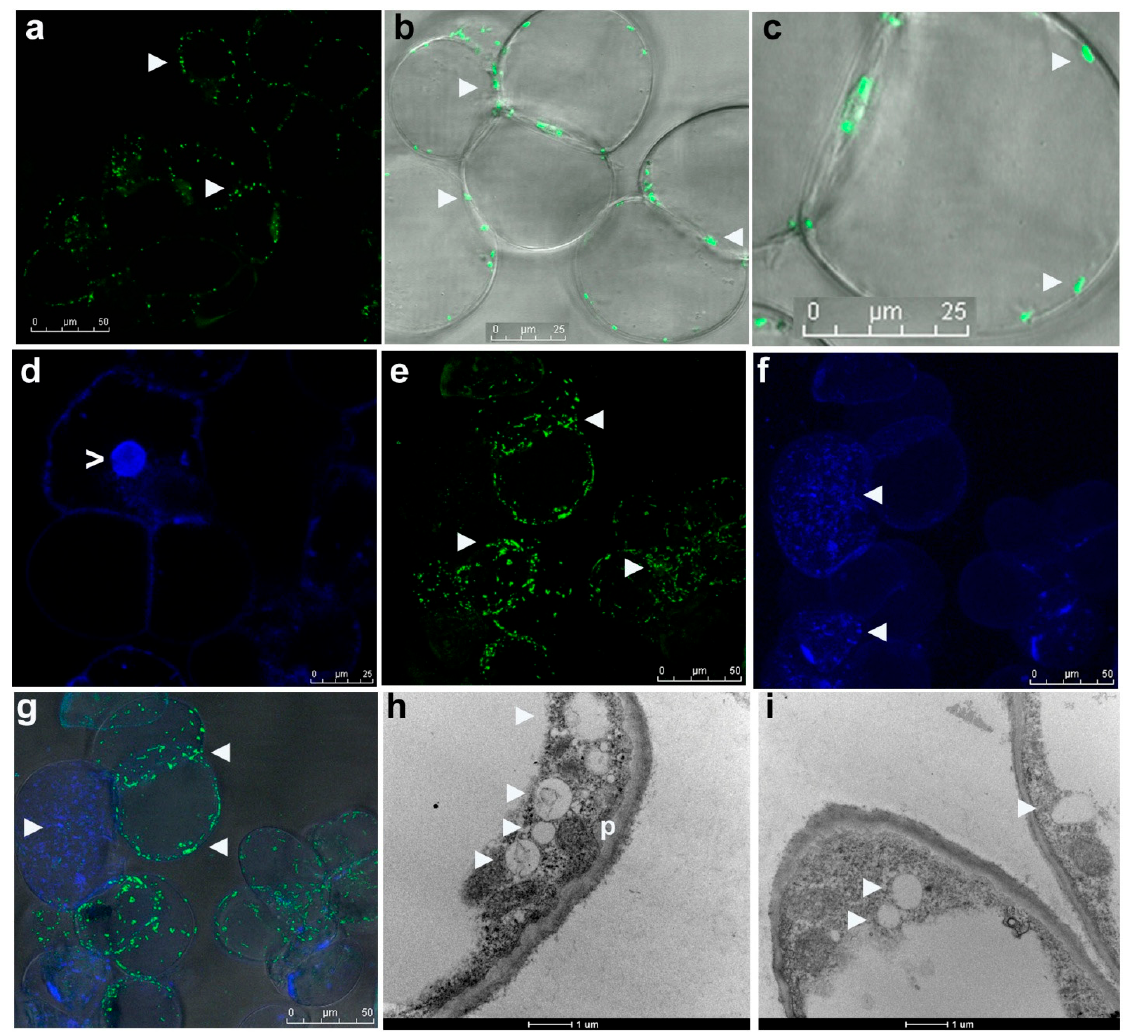
Figure 3. Confocal laser scanning microscopy (63× objective; ( a – g )) on grape “FU01” cells stained with SYTO-9, PI or DAPI and electron microscopy ( h , i ). ( a ) Fresh cells stained with SYTO-9 in water show bacterial cells along the cell outline, ( b ) combined image under DIC show bacterial cells confined to the host cell along the periphery, ( c ) an enlarged view of cell with green-fluorescing bacteria, ( d ) DAPI staining of cytoplasmic bacteria and a part of perispace organisms coupled with nuclear staining, ( e ) stacking the confocal images from different cell planes over 30 µm from SYTO-9, ( f ) with DAPI or ( g ) both together displaying heavy colonization of host cells with perispace and cytoplasmic bacteria, ( h , i ) transmission electron microscopy showing bacterial cells in the cytoplasmic matrix as lightly stained cocci of ≤ 1 µm, indicated by arrowhead along with dark-stained peroxisomes of similar size marked as “p” (bar = 1 µm; symbols ► and > indicate bacterial cells and nuclei, respectively; bar length as marked in the figure).